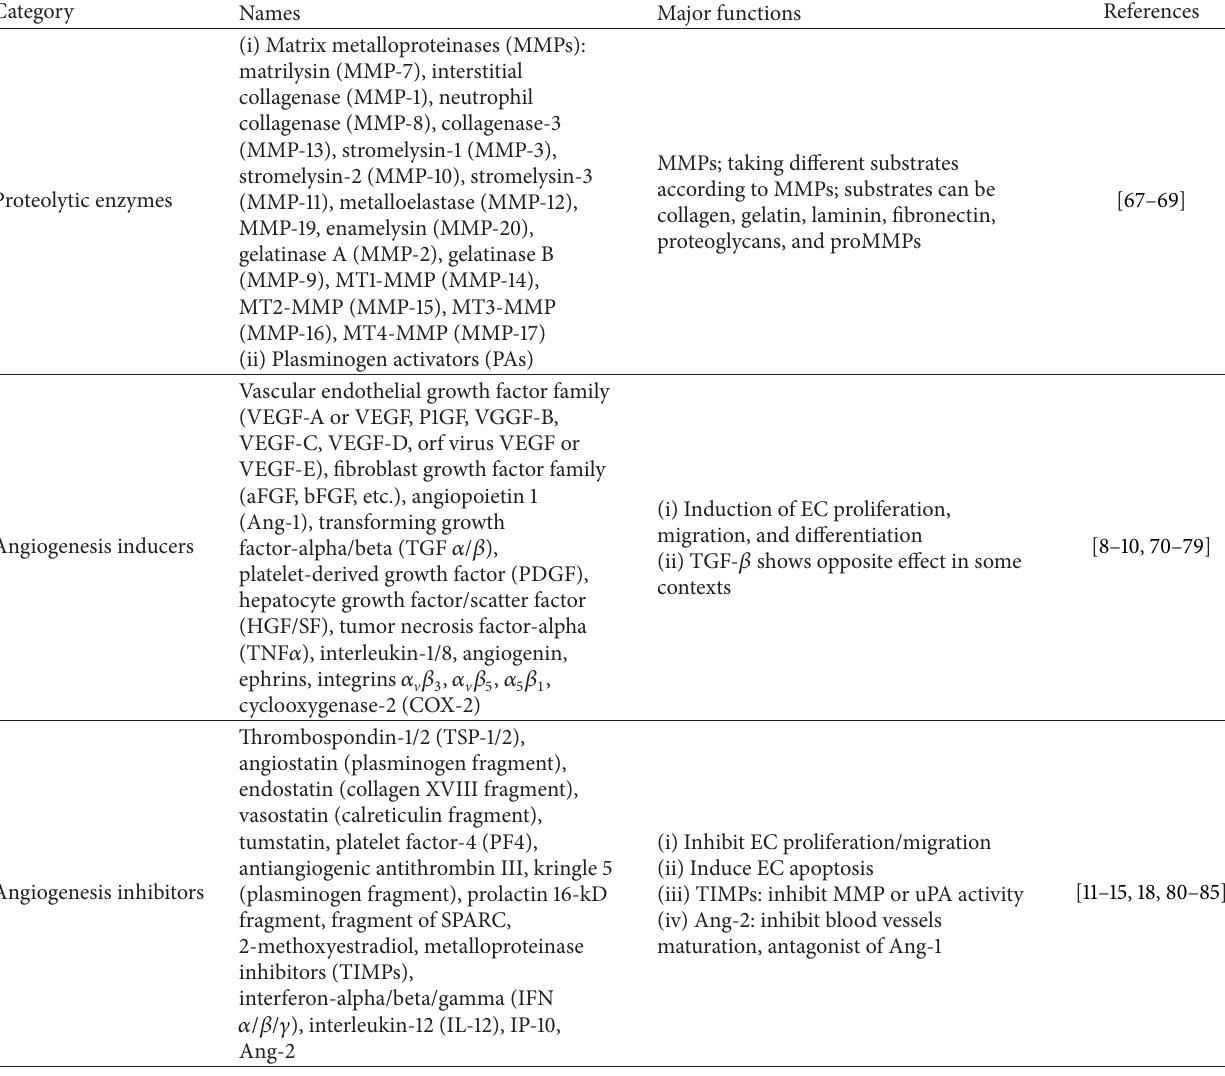
Table 1: Overview of the different angiogenic